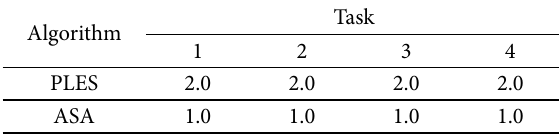
Table 11. Average rankings of the algorithms for group transportation